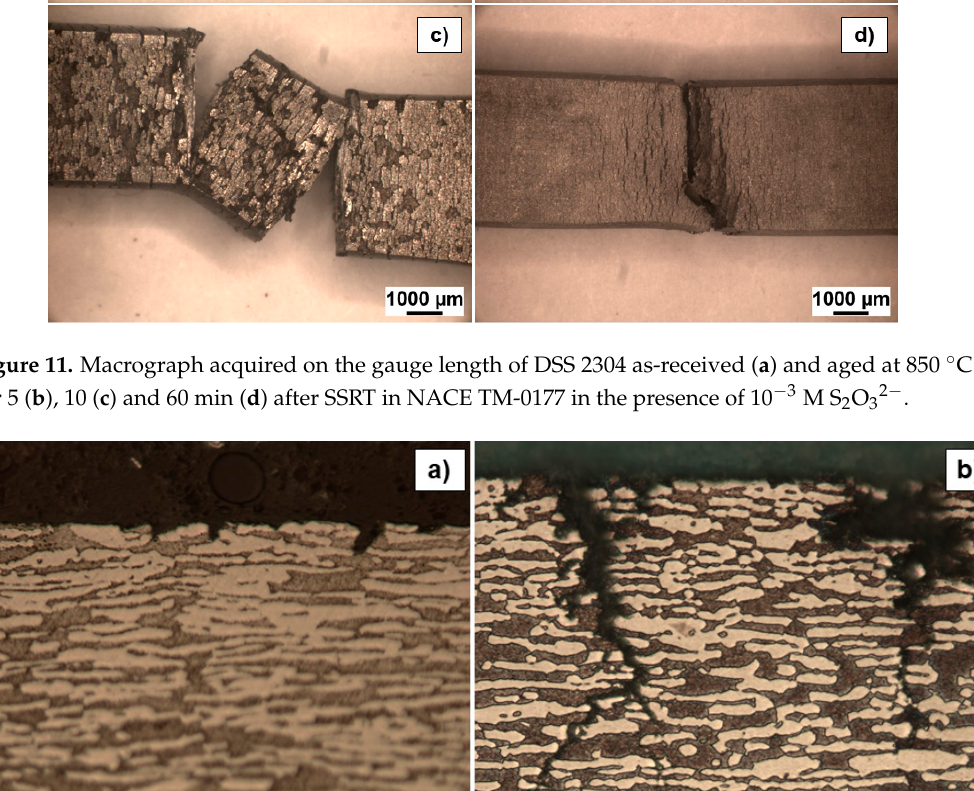
Figure 11. Macrograph acquired on the gauge length of DSS 2304 as-received ( a ) and aged at 850 °C for 5 ( b ), 10 ( c ) and 60 min ( d ) after SSRT in NACE TM-0177 in the presence of 10 − 3 M S 2 O 32 − .